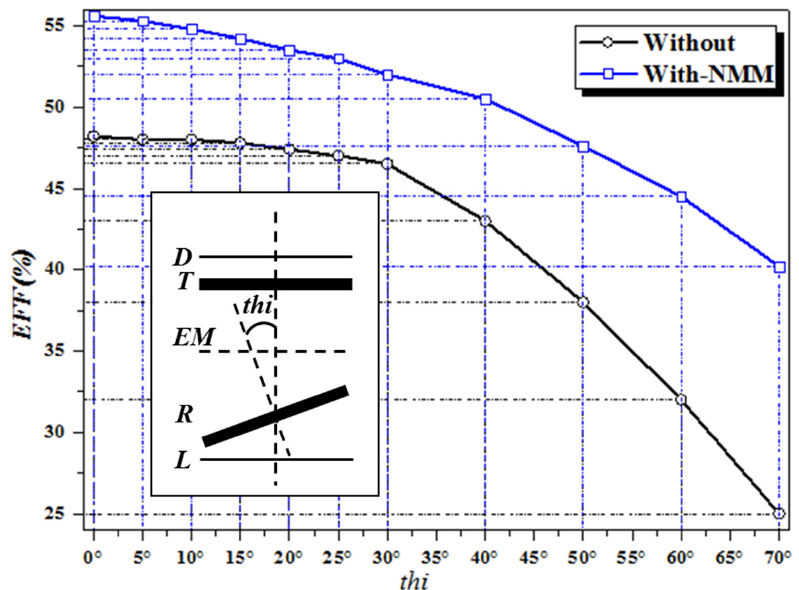
ffi ciency before and after NMM loading with angular o ff Figure 10. Comparison of system efficiency before and after NMM loading with angular offset . Figure 10. Comparison of system e